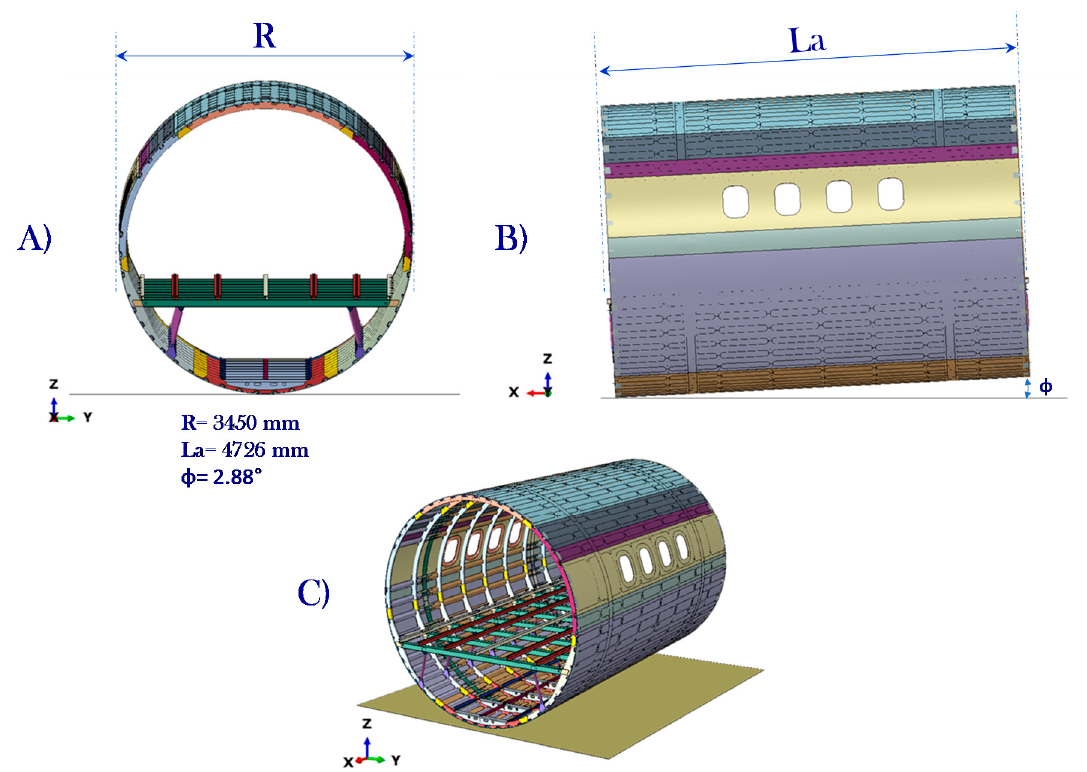
Figure 2. Fuselage section components. ( A ): Frontal view. ( B ): Lateral view. ( C ): Isometric view.